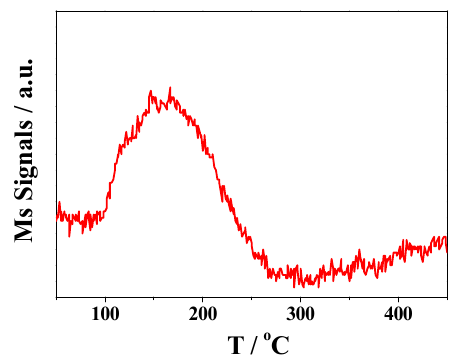
Figure 14. O 2 ‐ TPD ‐ MS profiles of used Ru/Al 2 O 3 ‐ NaBH 4 . Detection signals: 32 (O 2 ).